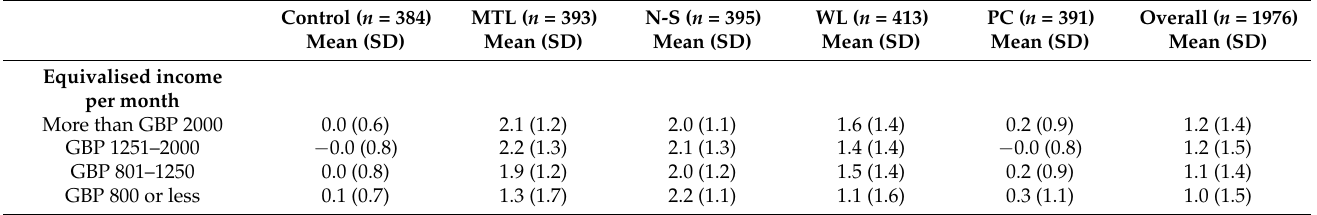
Table 7. Mean global food scores and standard deviations by experimental group and equivalised household income per